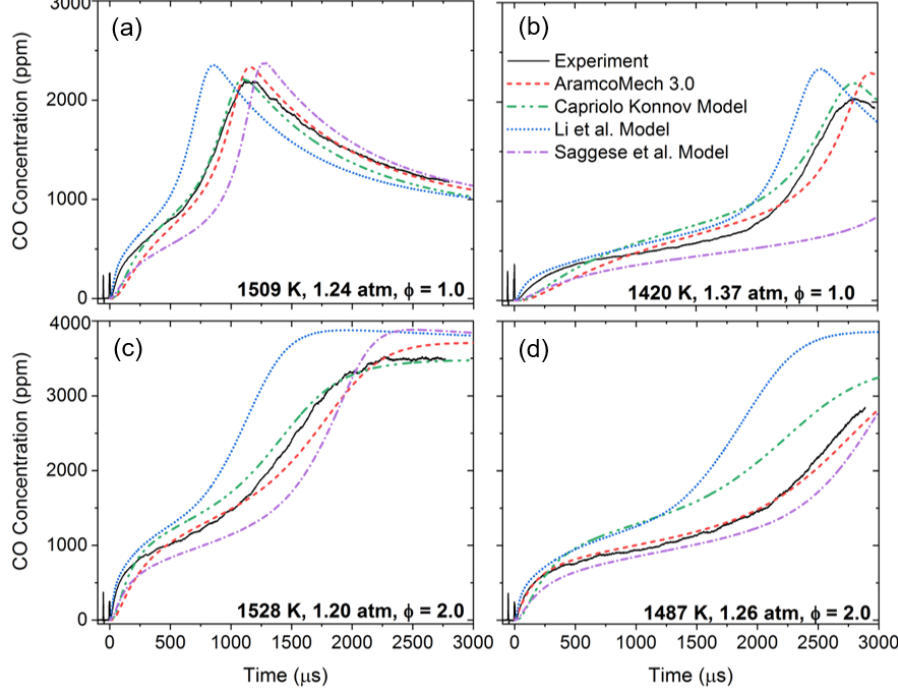
Figure 5. CO time history results for isopropanol oxidation at φ = 1.0 (a,b) and 2.0 (c,d) around 1.3 atm for intermediate- ( a , c ) and low-temperature ( b , d ) cases. 1.3 atm for intermediate- ( a , c ) and low-temperature ( b , d )